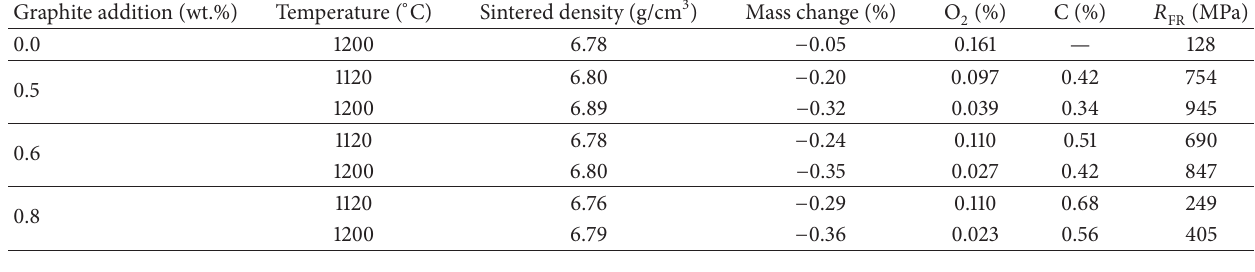
Table 10: Mass change and oxygen and carbon contents in AstCrM + C material with density of 6.8g/cm 3 sintered at 1200 ∘ C in relation to graphite addition.